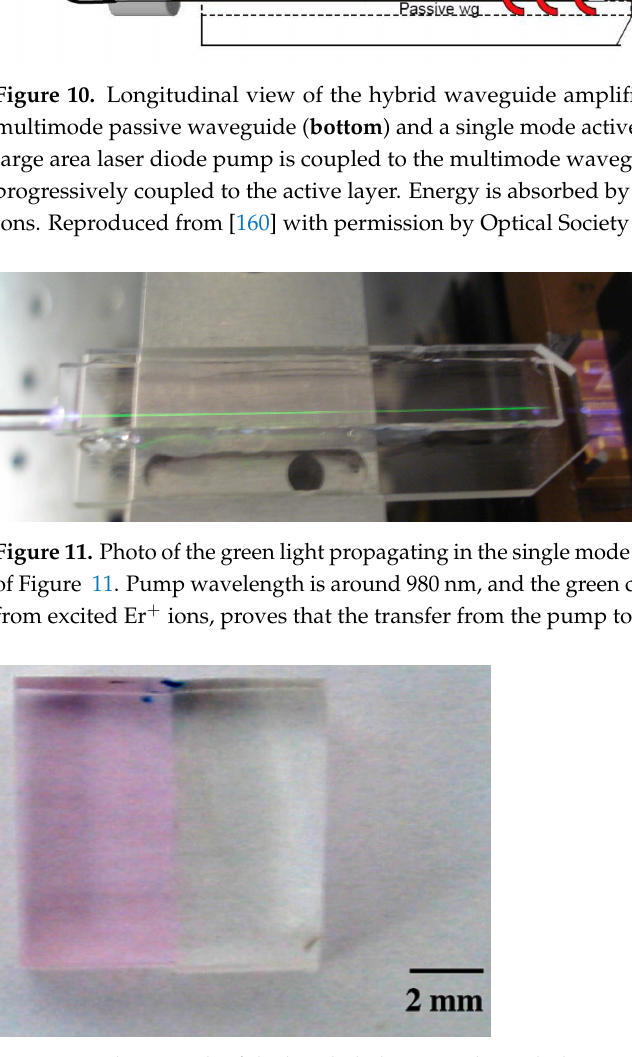
Figure 12. Photograph of the bonded glass sample, with the active ( pink ) and passive ( transparent ) parts. Reproduced from [179] with permission by